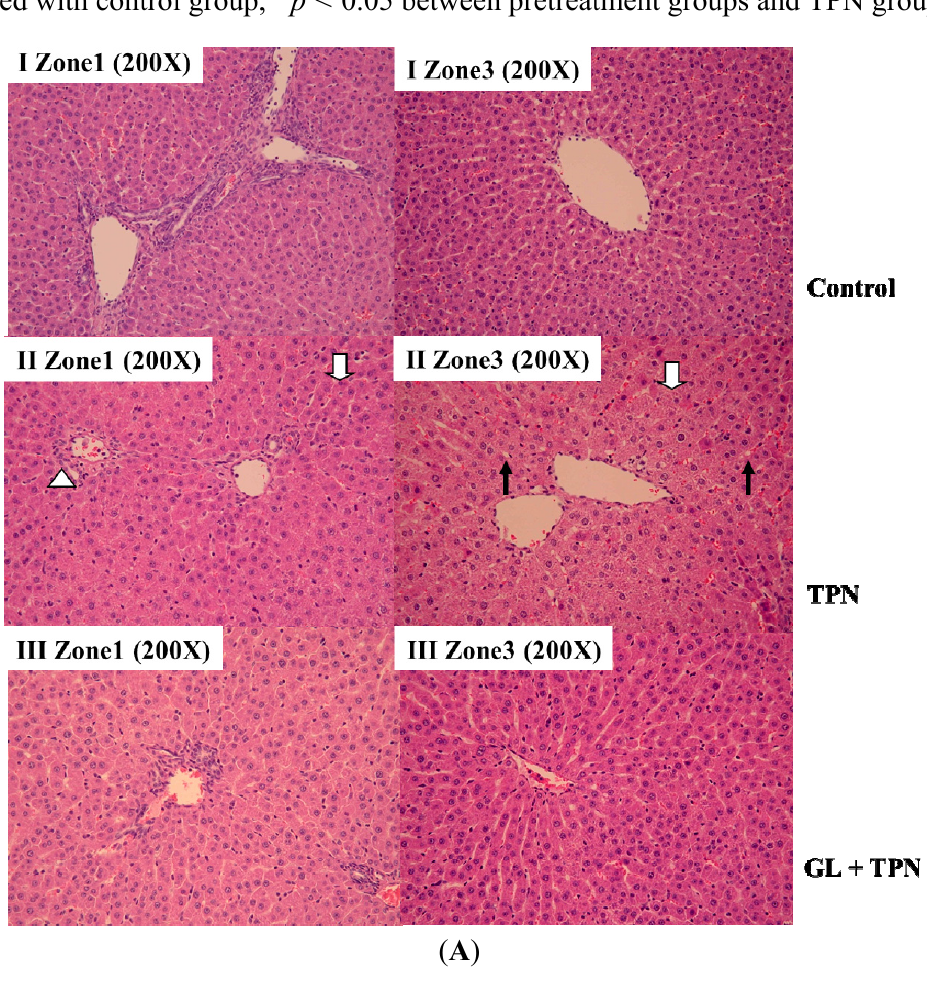
Figure 2. Histological examination of the effect of glycyrrhizin (GL) on total parenteral nutrition (TPN) rats. The livers were H&E-stained to examine the portal (zone) and terminal hepatic venules (Zone 3). ( A ) Saline infusion control (I); TPN infusion without treatment (II); and GL pretreatment (10 mg/kg) before TPN infusion (III) staining of Zone 1 (left column) and Zone 3 (right column) of the liver. Liver pathology in the control group exhibited normal hepatocyte structure and arrangement. The TPN non-treated group exhibited damaged liver structure, as indicated by monocyte infiltration (open arrowhead), steatosis (filled arrow) and the presence of necrotic cells (open arrow). Pretreatment with GL (10 mg/kg) inhibited hepatocyte damage; ( B ) Quantitative evaluation of pathological examinations. Normal hepatocytes were counted from 10 random fields (200× magnification) of each liver sample and the values represent the mean ± SD of six rats. * p < 0.05, compared with control group, # p < 0.05 between pretreatment groups and TPN